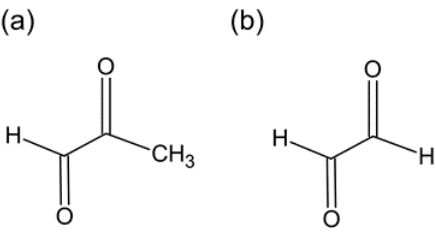
Figure 1. Advanced glycation end products (AGE)-related molecules. ( a ) Methylglyoxal, ( b ) α-